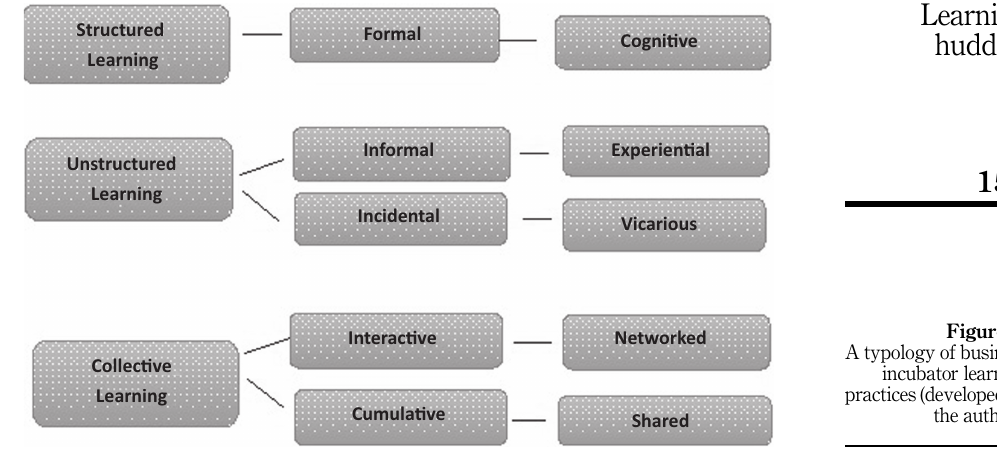
Figure 3. A typology of